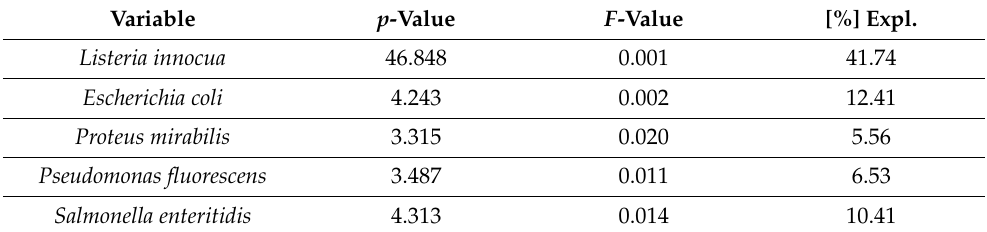
Table 3. Statistical parameters for the CCA analysis (Figure 6).